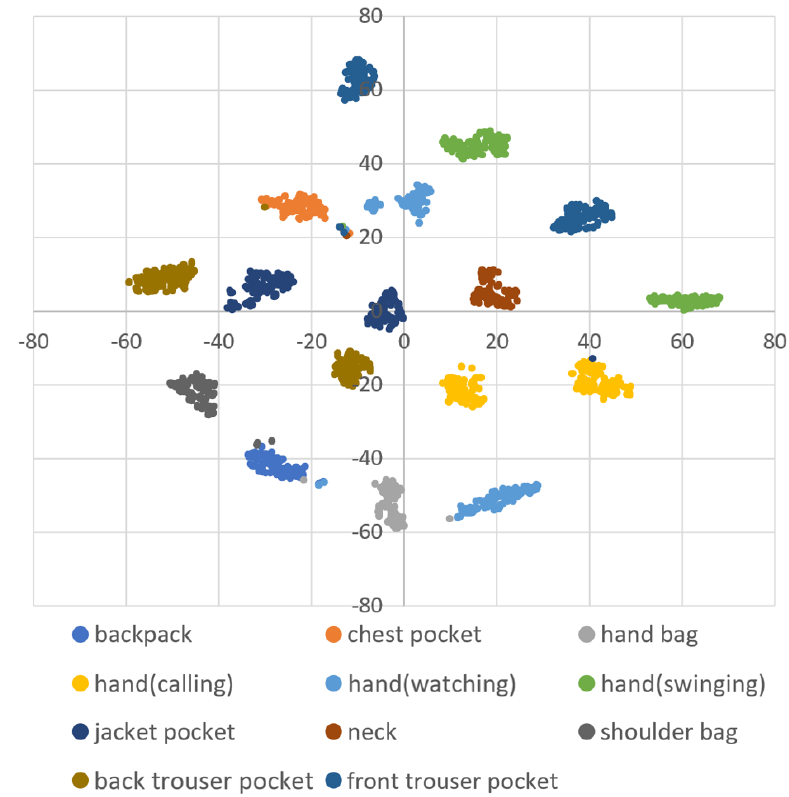
Figure 3. A two-dimensional visualization of the data of one subject using t-distributed stochastic neighbor embedding (t-SNE) in dataset